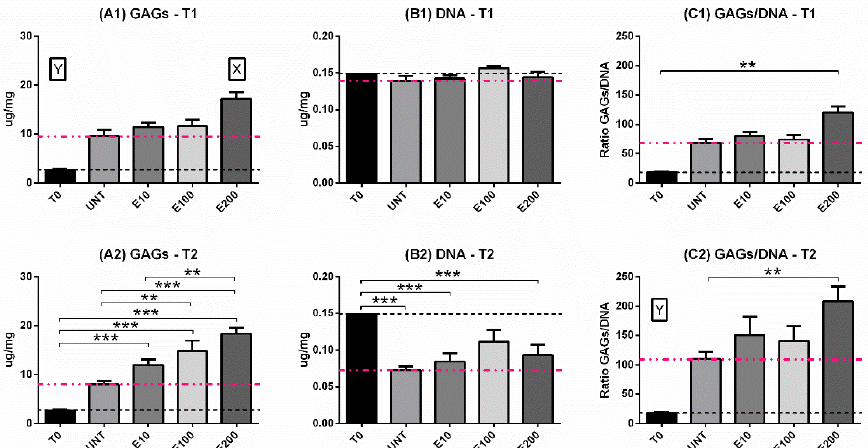
Figure 5. Biochemical analysis: GAGs ( A1 , A2 ) and DNA ( B1 , B2 ) content and their ratio GAG/DNA ( C1 , C2 ). Comparison between the time points (9 days = T1 and 21 days= T2) for all treatments. Two-way ANOVA and Tukey’s multiple comparisons test were performed. N = 4; ** = p < 0.01; *** = p < 0.001. Z, Y and X were used when the treatment was significantly different (0.001, 0.01 and 0.05, respectively) from all other treatments and to T0 at the considered time point. Data were expressed as mean ± S.E.M. The dashed black line is the expression level corresponding to T0, while the pink one corresponds to the expression level of the UNT group.